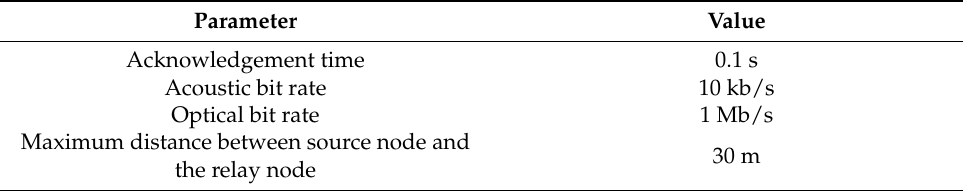
Table 3. OA-DLMA Parameters. Parameter